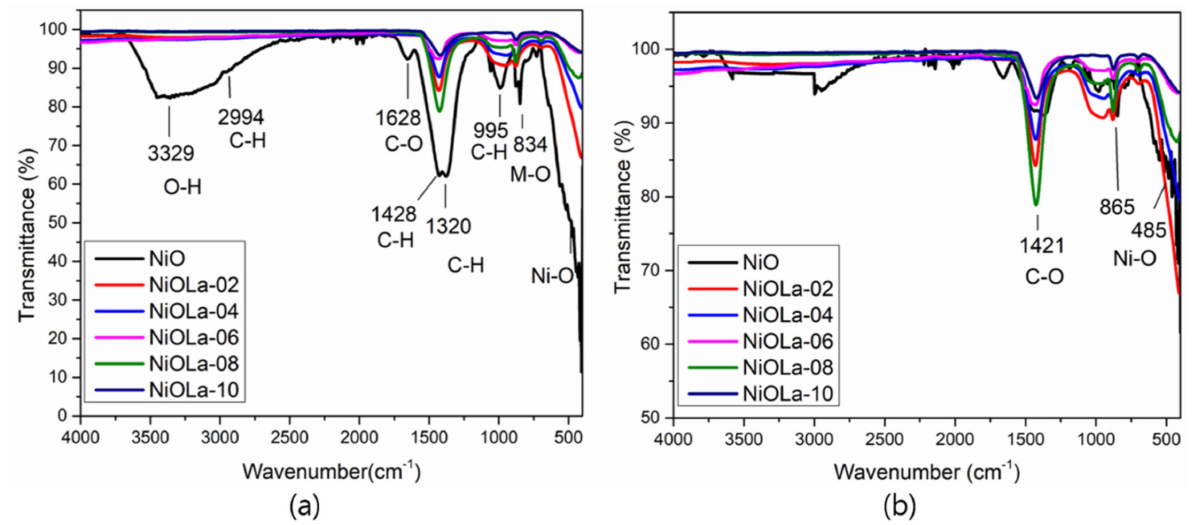
Figure 2. FTIR spectra of La 3+ ion-doped NiO nanoparticles: ( a ) before annealing; ( b ) after annealing.